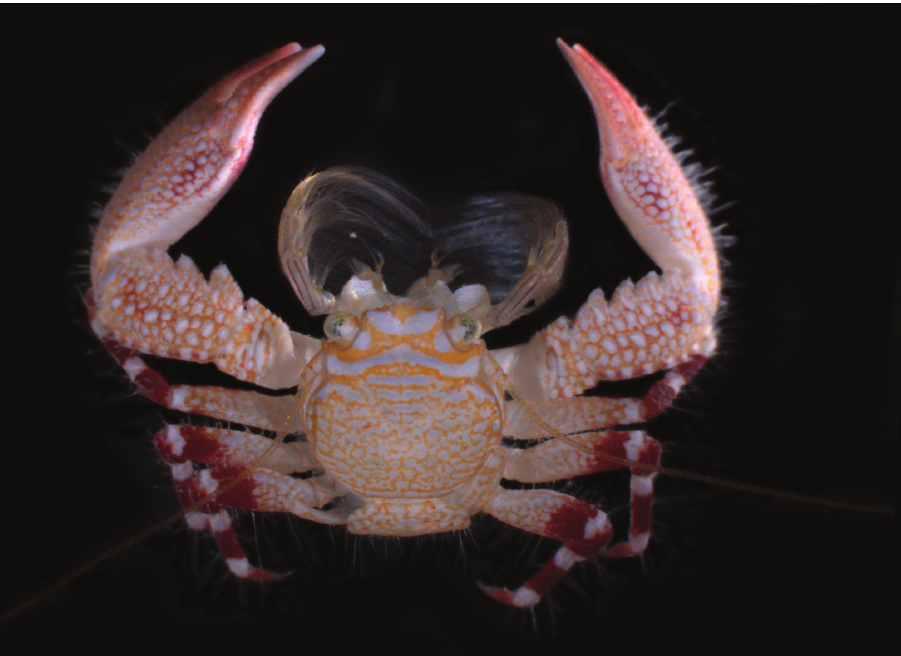
Figure 3. Petrolisthes paulayi sp. n., UF15894, Society Islands, Moorea. Photographed by the Moorea Bio- code Marine Invertebrate Team (catalogue number dMBC08_03896, Florida Museum of Natural History).